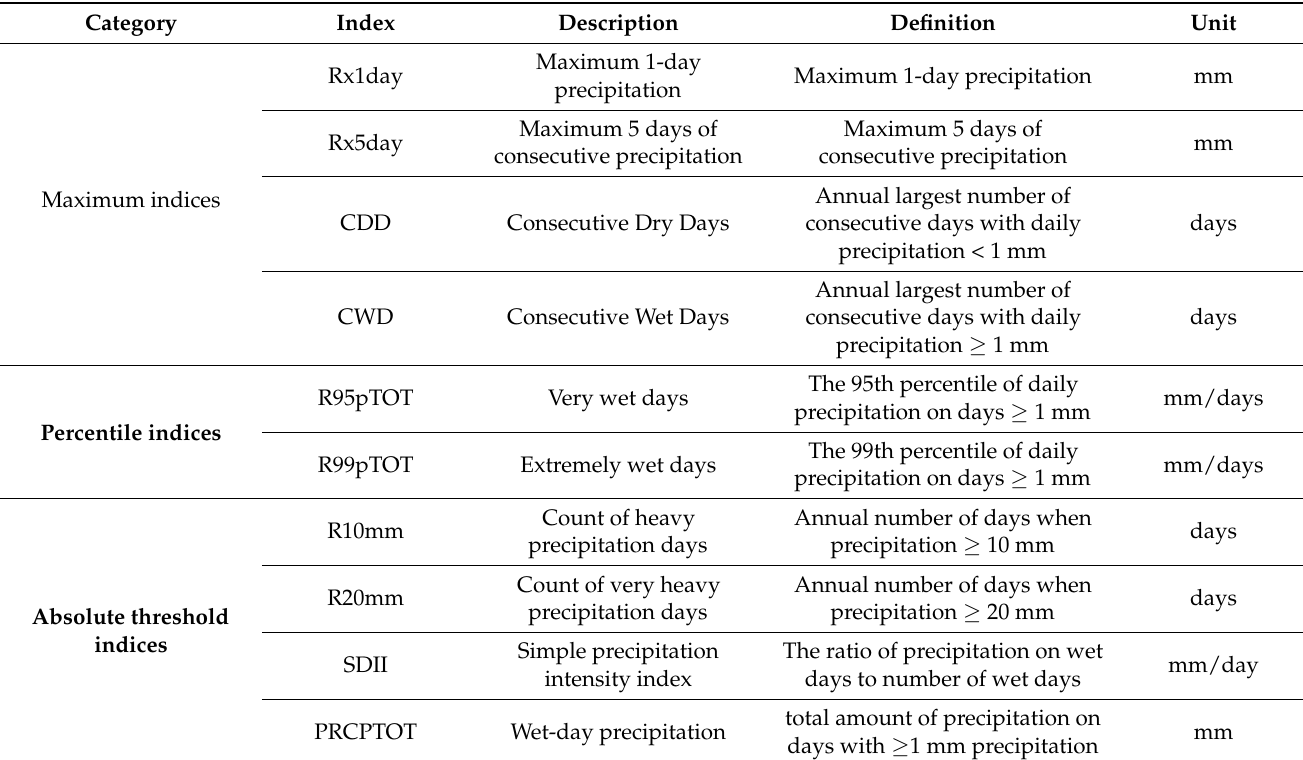
Table 1. List of extreme precipitation indices used in this